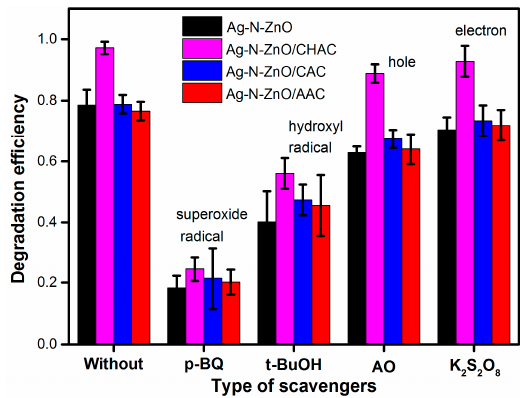
Figure 9. The removal rate of MO over Ag-N-ZnO/ACs in the presence of various scavengers.